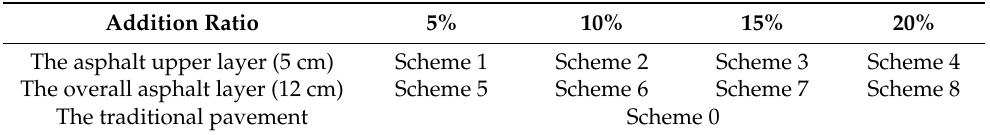
Table 3. PCM addition